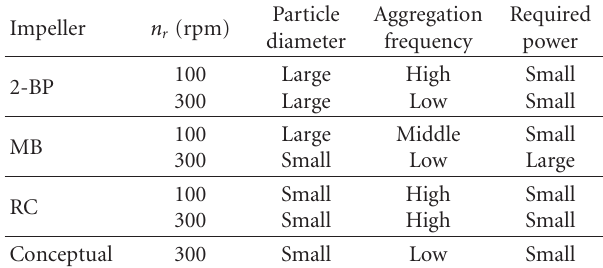
Figure 5: The particle diameter of TBAB hydrate and its distribution for three types of impeller; (a) n r = 100 rpm, (b) n r = 300 rpm. Table 3: The relative results of important factors for the preparation of TBAB hydrate slurries in various impellers. Herein, the boundary between “small” and “large” is defined at the value of 1.0 mm (particle diameter) and 1.0W (required power). The indexes of “low” and “high” mean the value of < 5% and > 10%, respectively, and “middle” does the value between